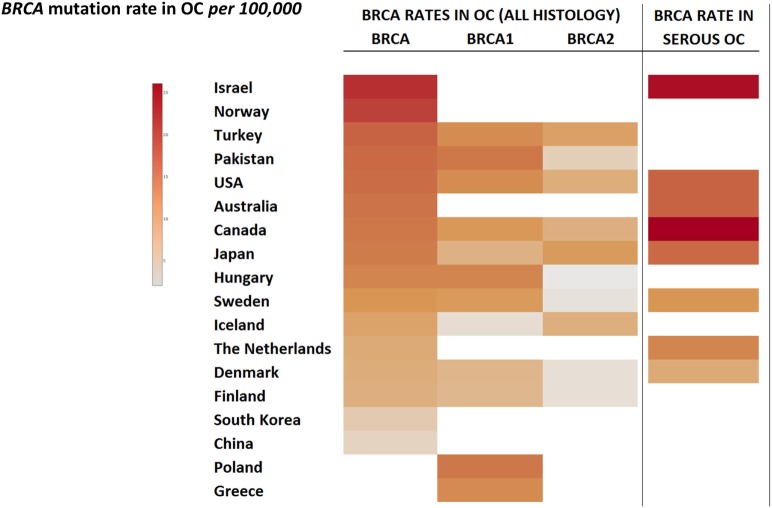
Germline BRCA1/2 mutational frequencies worldwide – examples.